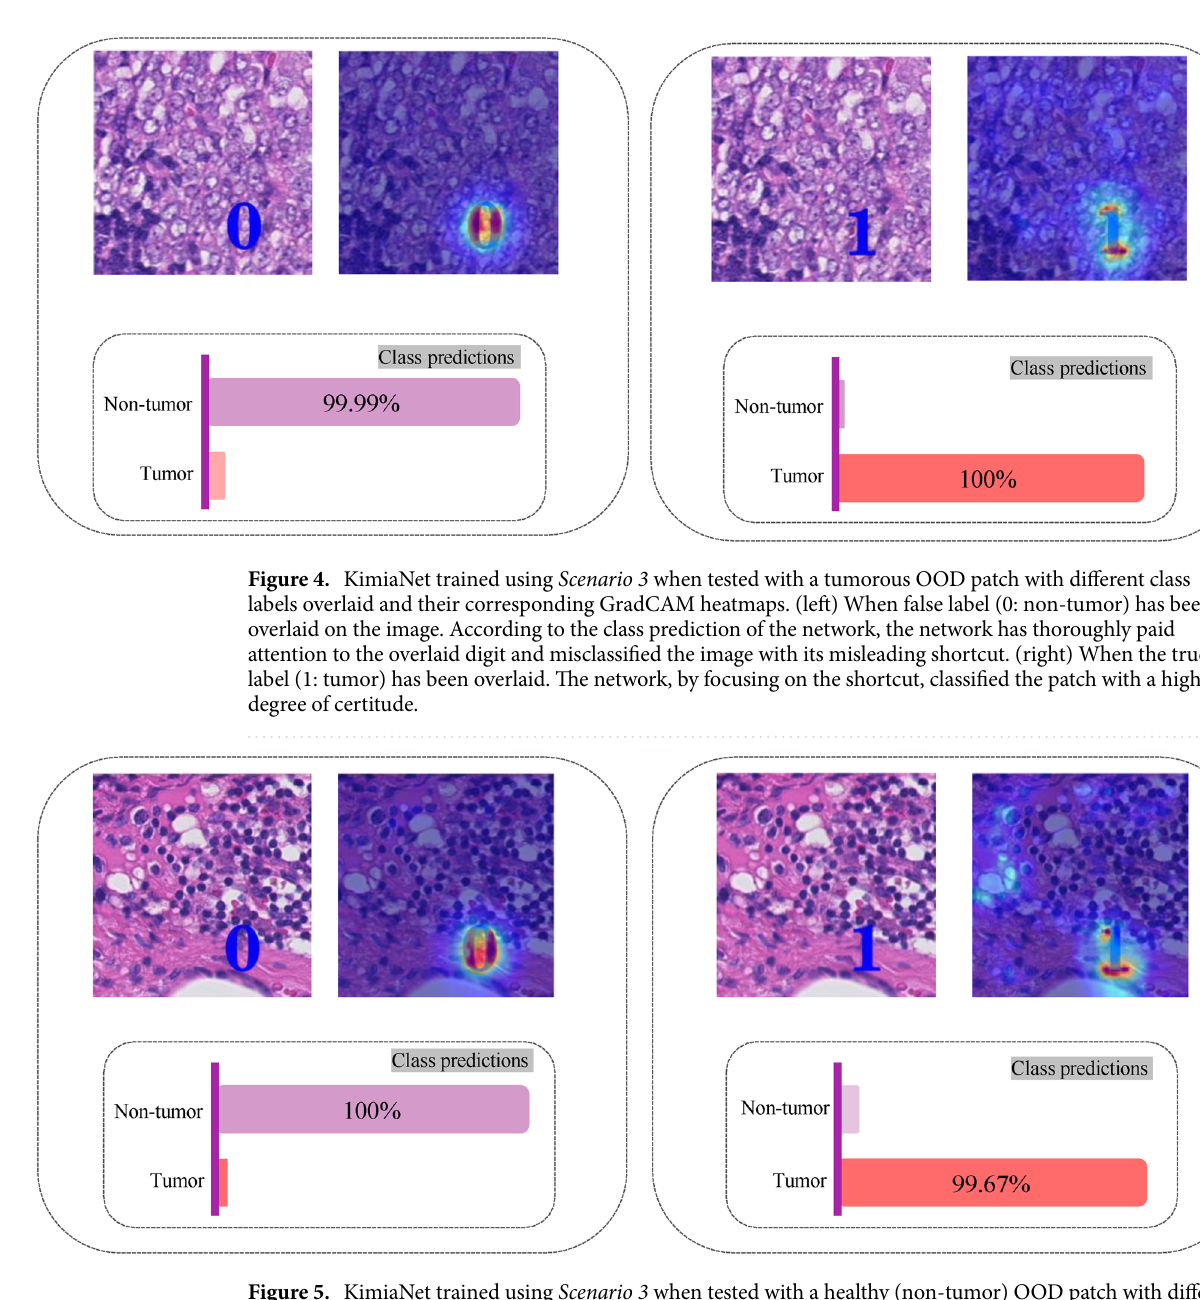
Figure 5. KimiaNet trained using Scenario 3 when tested with a healthy (non-tumor) OOD patch with different class labels overlaid and their corresponding GradCAM heatmaps. (left) When true label (0: non-tumor) has been overlaid on the image. The network, by relying on the shortcut, classified the patch with confidence. (right) When the false label (1: tumor) has been overlaid. According to the class prediction of the network, the network has thoroughly paid attention to the overlaid digit and misclassified the image with its misleading